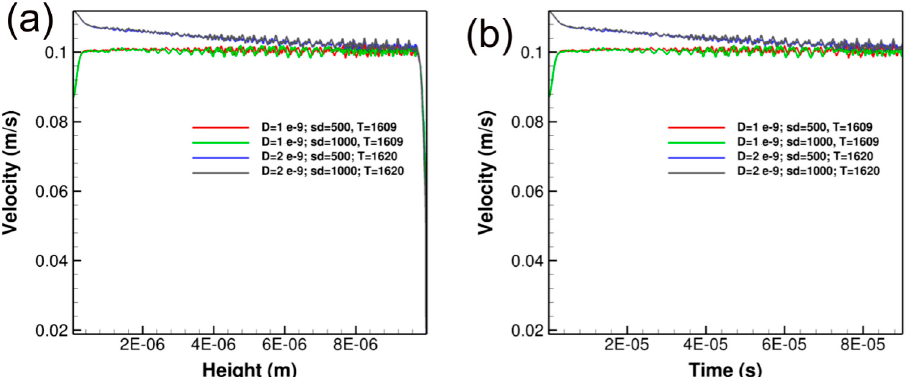
Figure 6. Growth curves as a function of ( a ) height and ( b ) solidification time for steady-state solidification in 2D with a thermal gradient of 2.6 × 10 6 K/m in the liquid and a steady-state s-l interface velocity of 0.1 m/s.